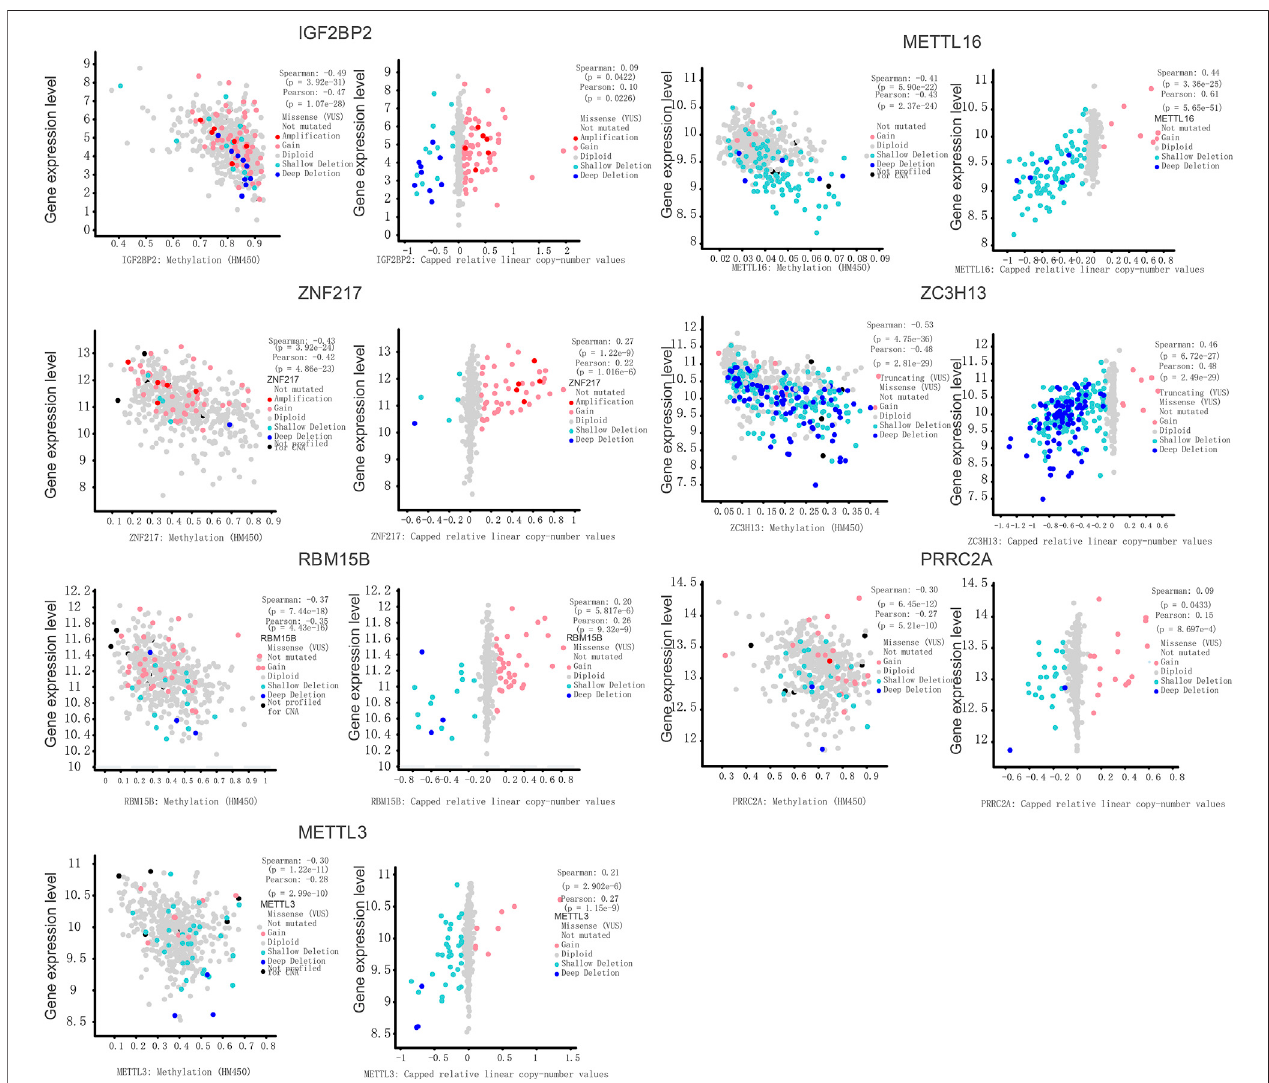
FIGURE 3 | Copy-number values(CNV) of m6A regulators and capped relative linear CNVs.